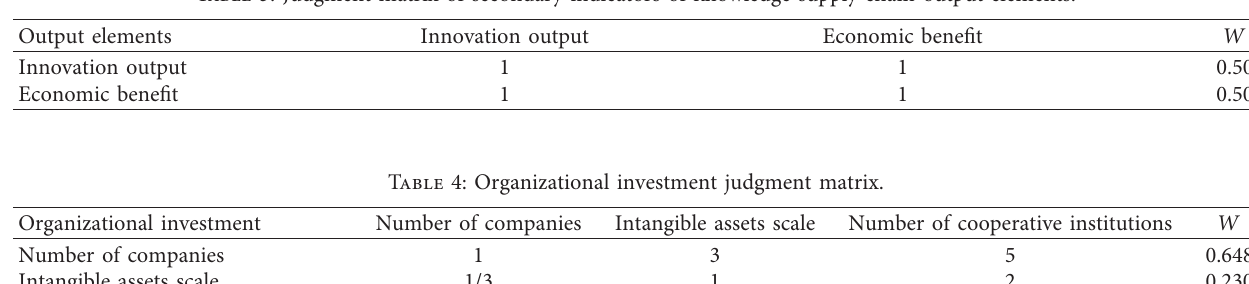
Table 3: Judgment matrix of secondary indicators of knowledge supply chain-output elements.